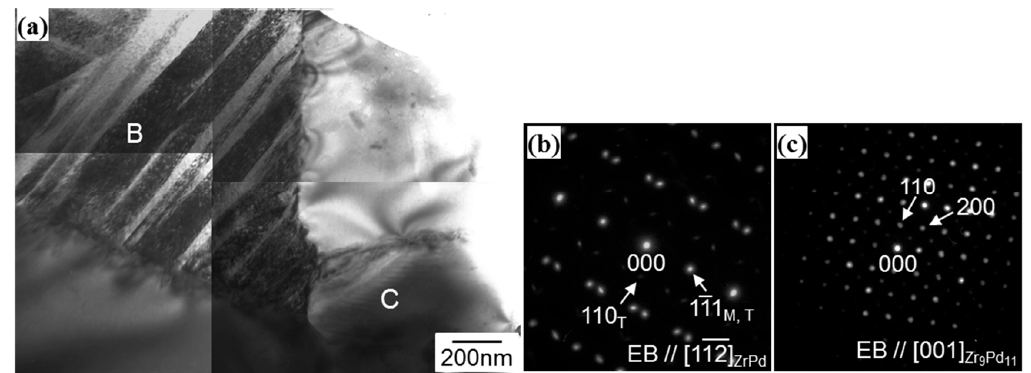
Figure 5. ( a ) Bright field image of the Zr-51 atom % Pd alloy aged at 1173 K for 720 ks. ( b , c ) Electron diffraction patterns taken from the areas marked B and C in ( a ), respectively. The pattern shown in ( b ) shows a (111) ZrPd twin pattern of ZrPd martensitic phase as well as Figure 2. The pattern shown in ( c ) is indexed according to the Zr 9 Pd 11 compound.